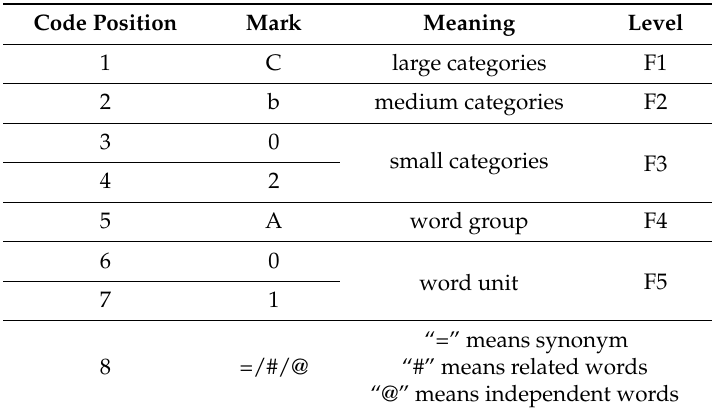
Table 1. Description for coding of